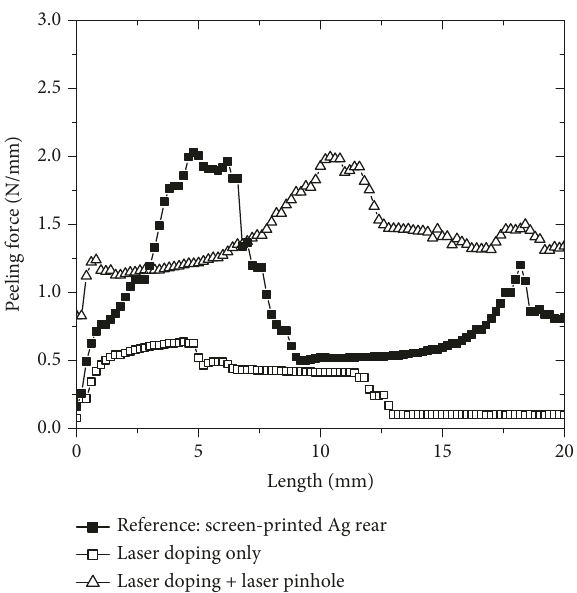
Figure 13: Peeling force pro fi les of SPMSCs with a B-BSF seed layer and EPC contact layer as the rear contacts. A peeling force pro fi le of a SPMSC with a screen-printed Ag rear was used as a